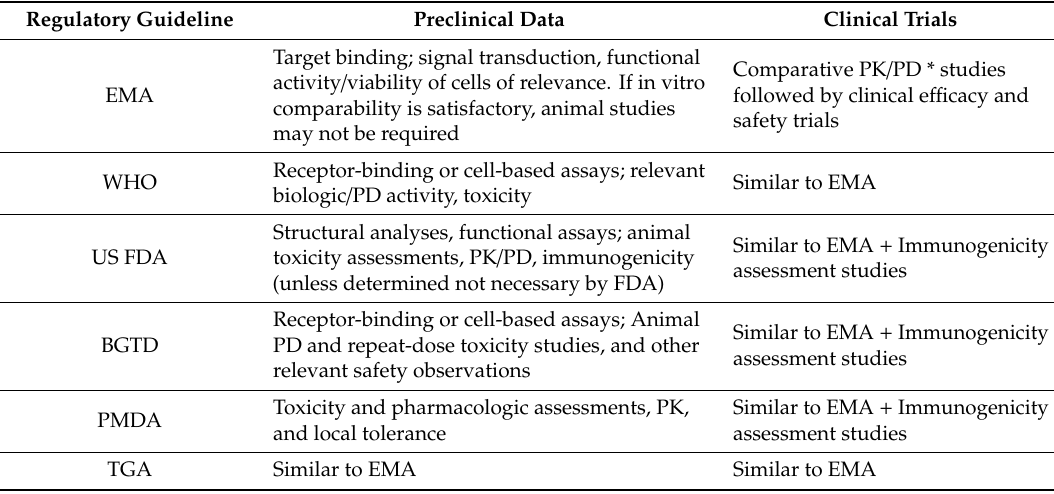
Table 2. Comparative overview of Preclinical Data studies and Clinical Trials established by the regulatory guidelines of EMA, WHO, US FDA, BGTD, PMDA, and TGA. Regulatory